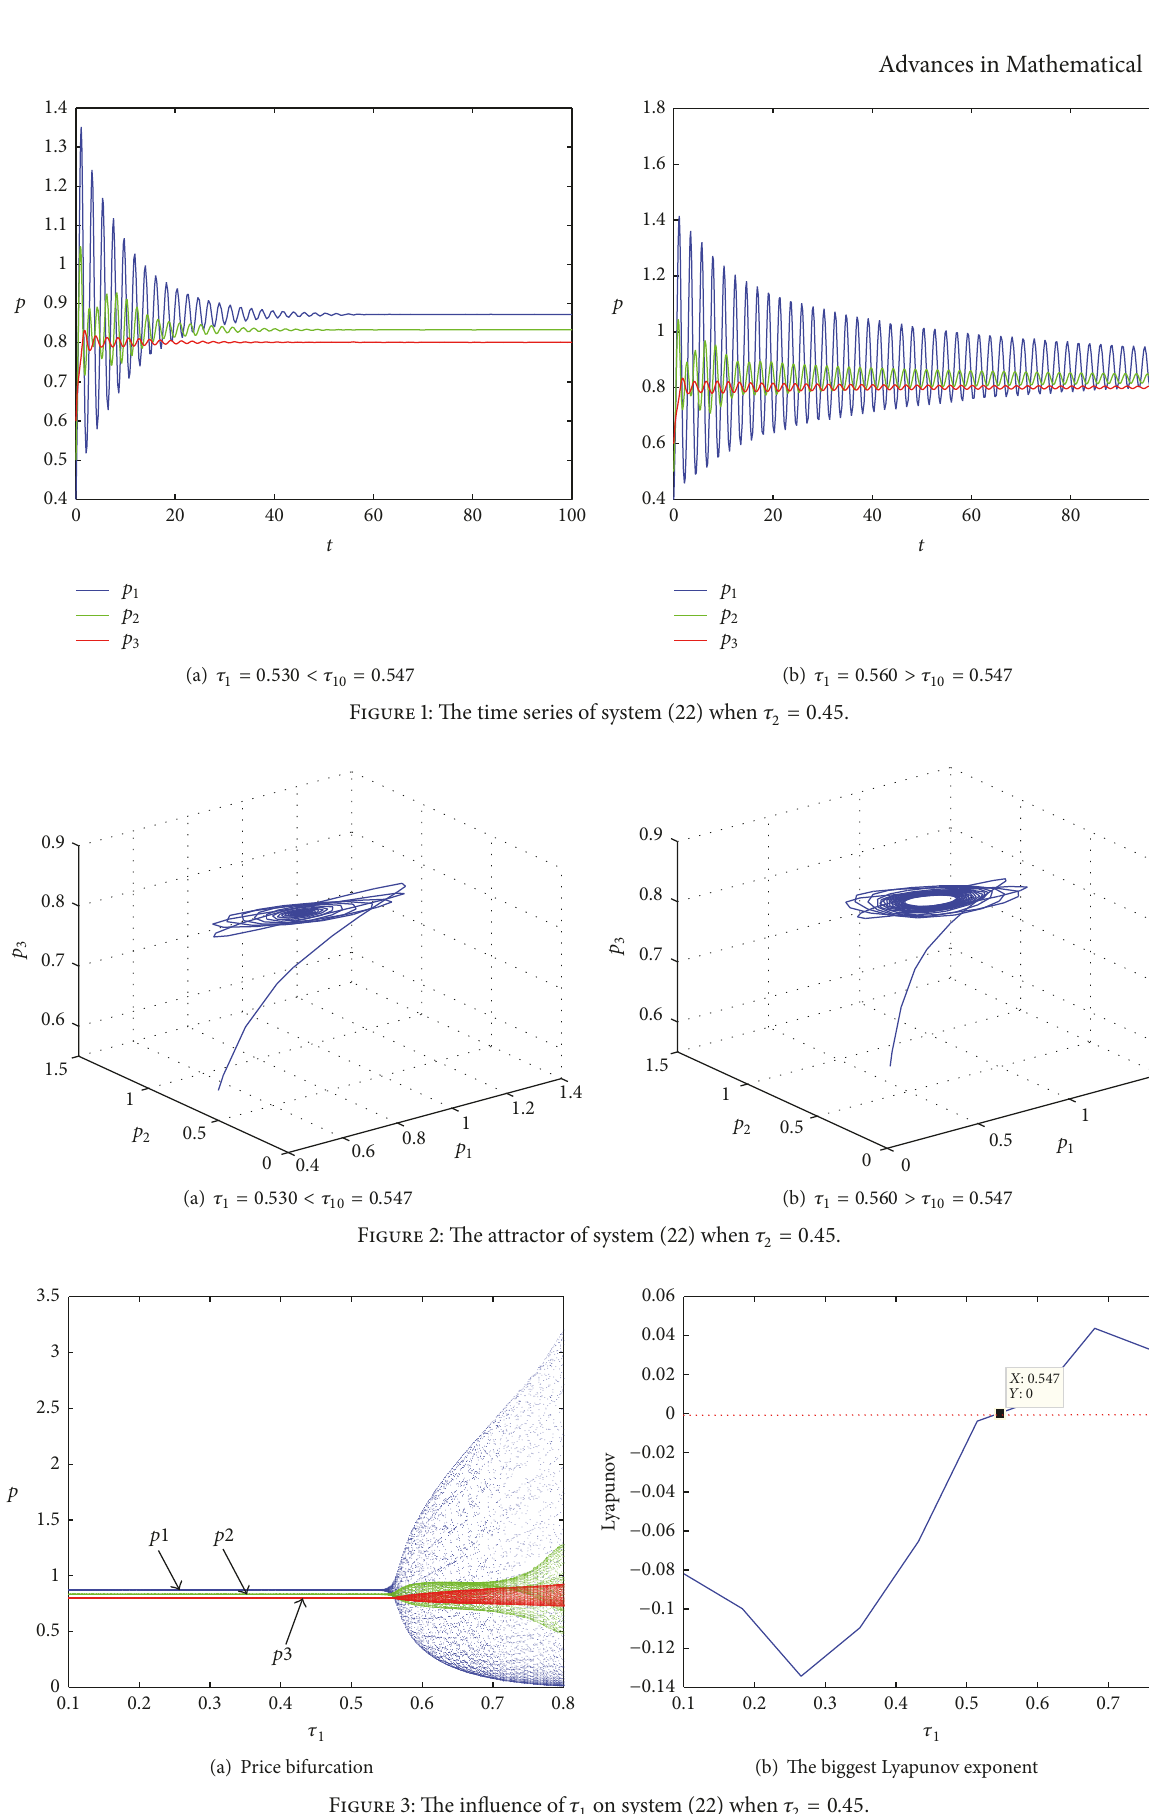
Figure 3: The influence of 𝜏 1 on system (22) when 𝜏 2 = 0.45